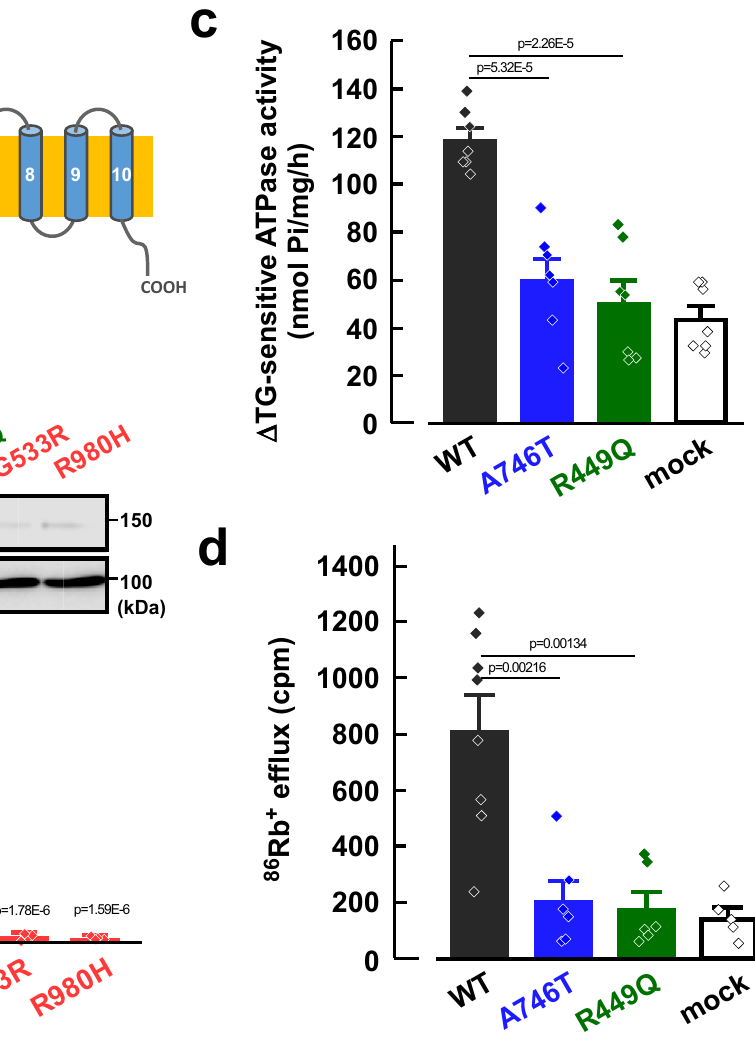
c Δ TG-sensitiveATP13A2activitiesweremeasuredinthemembranefractionsofthe ATP13A2 WT-, A746T, and R449Q-transfected HEK293 cells. ( n =7 independent replicates).Statisticalsigni fi cancewasdeterminedbytwo-tailedunpairedStudent ’ s t test. d The 86 Rb + ef fl uxesintheATP13A2WT-,A746T-andR449Q-transfectedcells. ( n =5 – 8 independent replicates). Statistical signi fi cance was determined by two- tailed unpaired Student ’ s t test. All data are presented as mean±SEM. Source data are provided as a source data fi